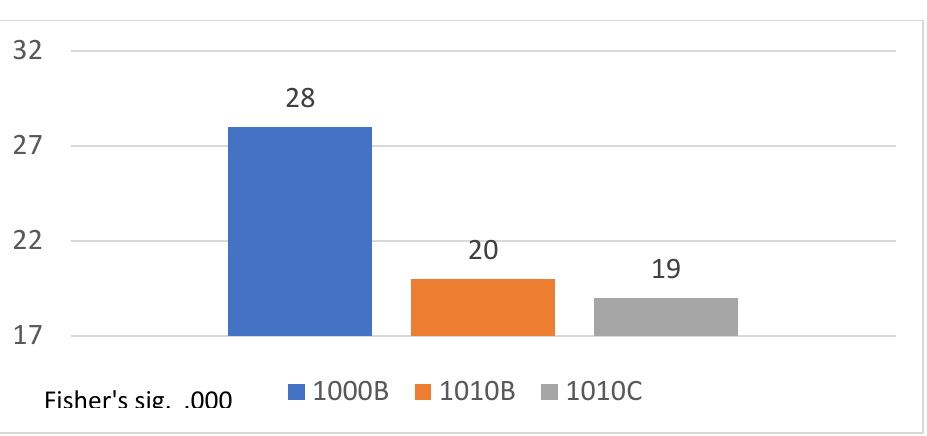
FIGURE 7. AGE BY COURSE